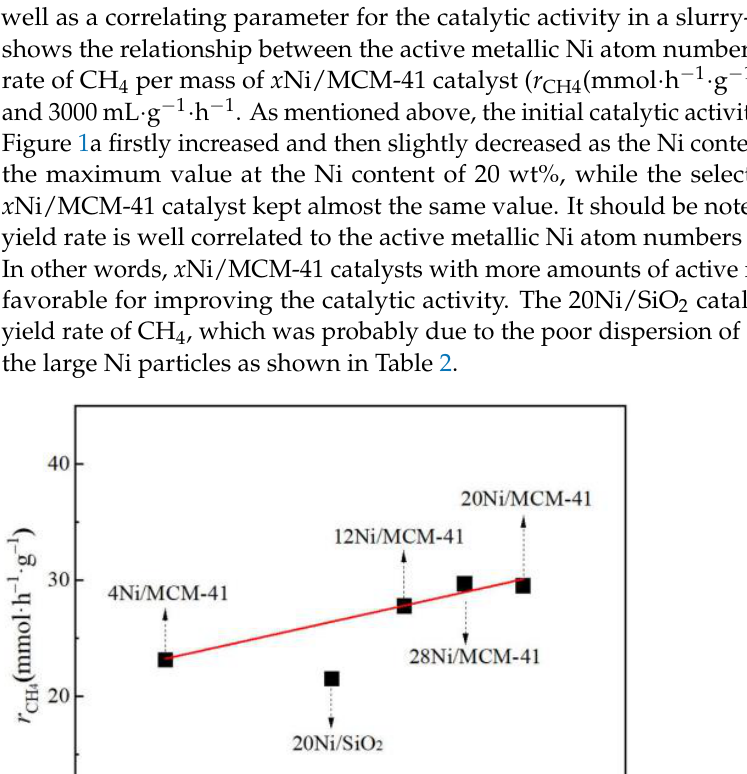
Figure 7. TEM images of MCM-41 support and calcined x Ni/MCM-41 catalysts. ( a ) MCM-41 support, ( b ) 4Ni/MCM-41 catalyst, ( c ) 20Ni/MCM-41 catalyst.